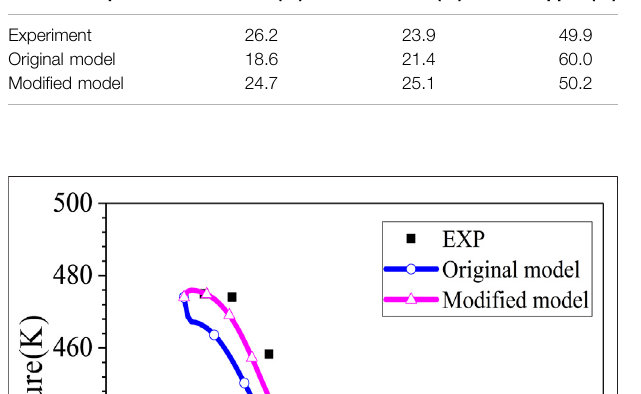
TABLE 6 | Condensation rate fraction on the three condensers in Phase B of MISTRA ISP47 experiment ( t (cid:1) 9000 s). Location of